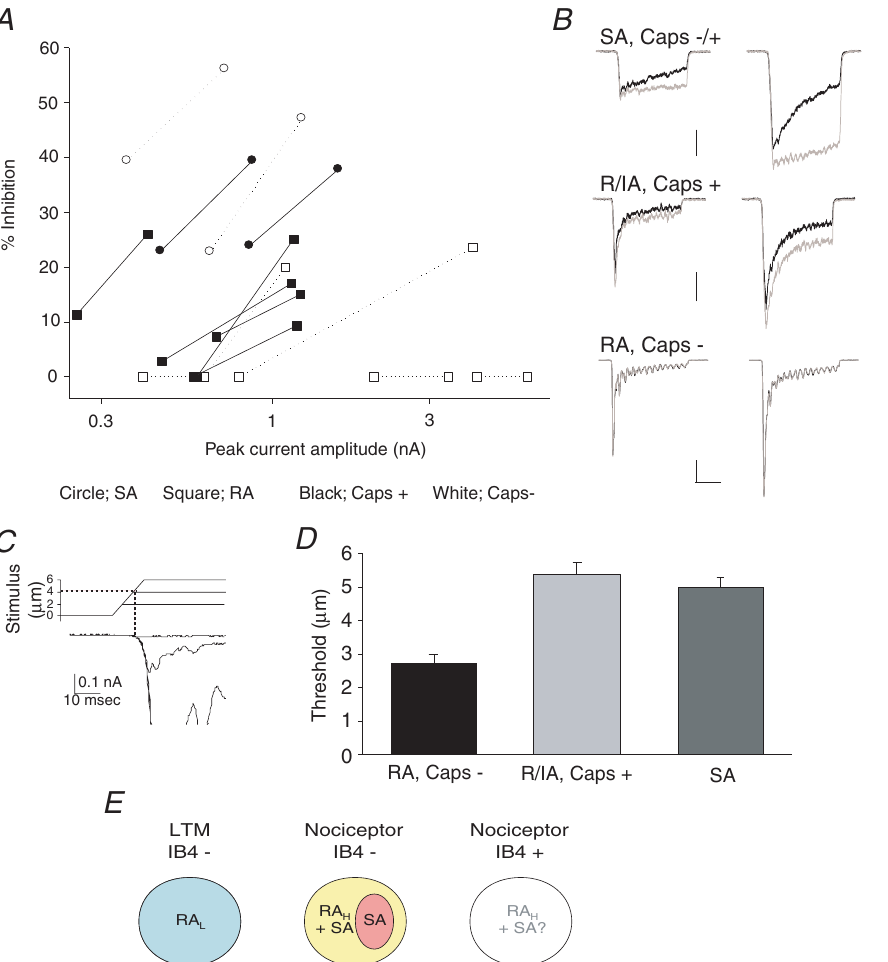
Figure 4. SA currents are more prevalent at high intensity mechanical stimuli; evidence from NMB-1 activity at 2 stimulus intensities and activation thresholds. ( A ) Blockade by 1 m M NMB-1 of currents evoked by 9 and 12 m m stimuli. Each connected pair of symbols on the graph represents a single neuron. The symbol on either end indicates the peak current amplitude and the level of inhibition of charge transfer by 1 m M NMB-1; the left-hand symbol represents the response to a 9 m m stimulus and the right-hand one the response to 12 m m. Capsaicin-sensitive neurons are represented by black symbols and solid lines, whereas capsaicin-insensitive neurons are shown by white symbols with dotted lines. SA currents are indicated by circles, and squares represent RA currents. The results show the heterogeneity of currents and the different ratios of NMB-1 sensitive and insensitive ion channels in each cell; NMB-1 has a greater inhibitory effect at the larger stimulus intensity and is most active in capsaicin-sensitive neurons and neurons with SA currents. In capsaicin-insensitive neurons with RA currents 2/5 are NMB-1 sensitive and only at a 12 m m stimulus. Only neurons with currents . 250 pA were selected for these experiments. ( B ). Example traces of currents (Grey=control, black=1 m M NMB-1) activated by 9 m m ( left ) and 12 m m ( right ) stimuli in a capsaicin sensitive neuron ( top ), a neuron with a SA current ( middle ) and a capsaicin insensitive neuron with a RA current ( bottom ). ( C ) Expanded view of a family of currents evoked by ascending mechanical steps showing that currents activate at a specific membrane displacement and how this allows extrapolation of the threshold of activation. ( D ) Graph shows the average activation thresholds for capsaicin insensitive neurons with RA currents (2.7 6 0.3 m m, n=31) that were lower than those of neurons with SA currents (5.0 6 0.3 m m, P , 0.001, n=9) and capsaicin sensitive neurons (5.4 6 0.4 m m, P , 0.001, n=32). ( E ) Schematic of ion channel distribution across subpopulations of DRG neurons. Each color represents a functional class of neurons and indicated are the MS channel types expressed by that class. doi:10.1371/journal.pone.0000515.g004 displayed toxin sensitivity. Conversely, in nociceptors (capsaicin- sensitive neurons) with RA currents, the toxin was active in all cells (5/5) at the higher stimulus intensity (currents decreased by 18.5 6 3.2%) but also had inhibitory actions in 3/5 neurons when stimulated by a 9 m m displacement. In these capsaicin-sensitive neurons, current adaptation (over 200 msec) decreased when the stimulus was increased from 9 to 12 m m (94.4 6 2.1% to 83.2 6 3.7%, P = 0.03. Fig. 4a, b), consistent with a relative increase in SA current amplitude. These experiments demonstrate that most neurons co-express RA and SA mechanosensitive ion channels but